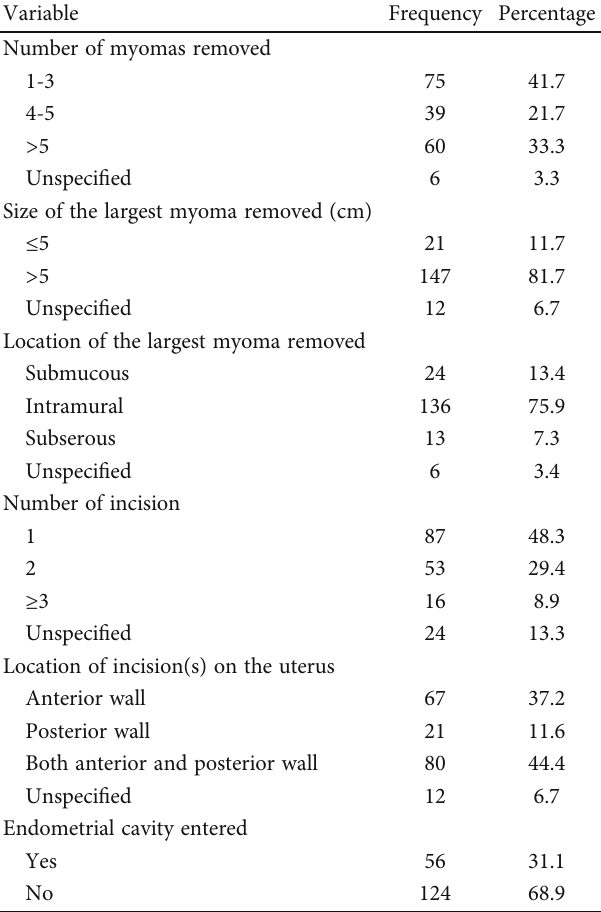
Table 3: Intraoperative fi nding of women who underwent myomectomy, SPHMMC, Addis Ababa, 2019.